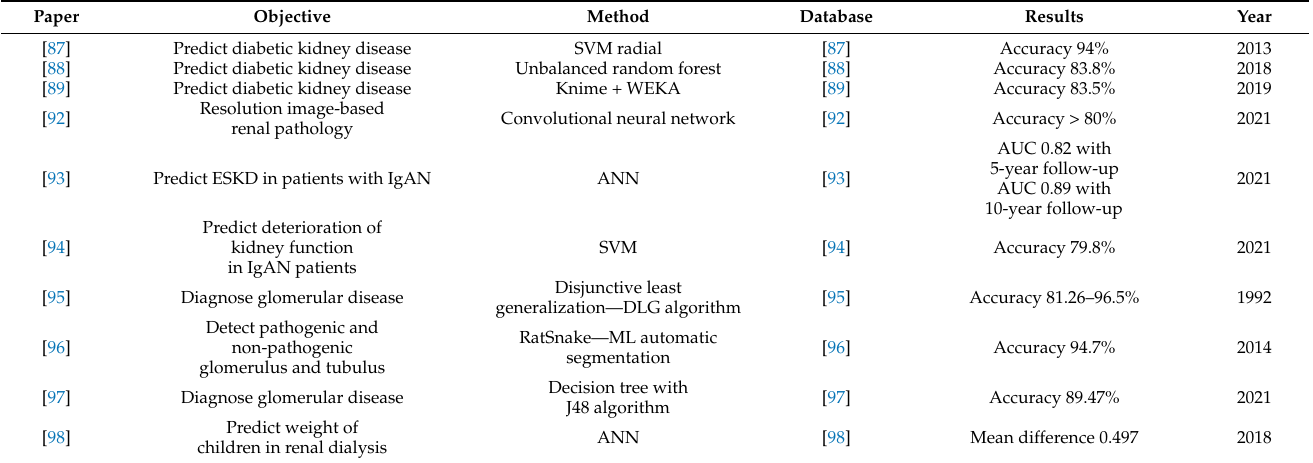
Table 5. Glomerular disease